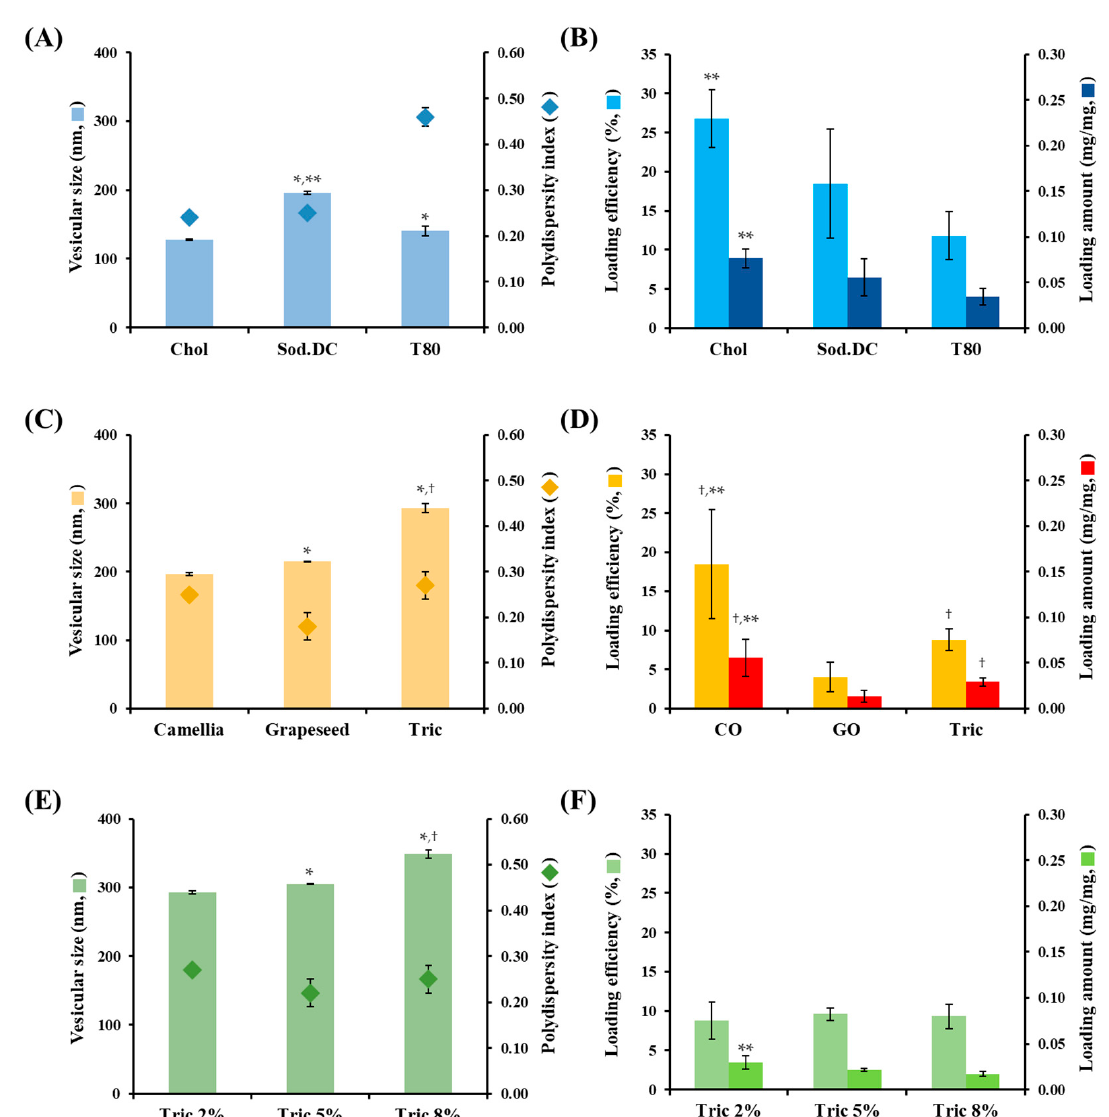
Figure 3. Effect of formulation variables on liposome vesicular size, polydispersity index, loading efficiency, and loading amount of Vit C. Effect of the type of edge activator on ( A ) vesicular size and polydispersity index and ( B ) Vit C loading efficiency and amount. Effect of kinds of neutral oil on ( C ) vesicular size, polydispersity index, and ( D ) Vit C loading efficiency and loading amount. Effect of the amount of Tric on ( E ) vesicular size and polydispersity index and ( F ) Vit C loading efficiency and loading amount. In ( A , B ), LOSs prepared with cholesterol (L1), sodium deoxycholate (L2), and polysorbate 80 were named Chol, Sod.DC, and T80, respectively. In ( C , D ), LOSs prepared with camellia oil (L2), grapeseed oil (L4), and tricaprylin (L5) were named CO, GO, and Tric, respectively. In ( E , F ), LOSs prepared with tricaprylin concentrations of 2% (L5), 5% (L6), and 8% (L7) were named Tric 2%, Tric 5%, and Tric 8%, respectively. The polydispersity index was obtained from the Zetasizer measurement. Data represent mean ± SD (n = 3). In ( A , B ), significant differences from Chol ( * p < 0.05) and T80 ( ** p < 0.05) were calculated using the ANOVA test. In ( C , D ), significant differences from CO ( * p < 0.05), GO ( † p < 0.05), and Tric ( ** p < 0.05) were calculated using the ANOVA test. In ( E , F ), significant differences from Tric 2% ( * p < 0.05), Tric 5% ( † p < 0.05) and T80 ( ** p < 0.05) were calculated using the ANOVA